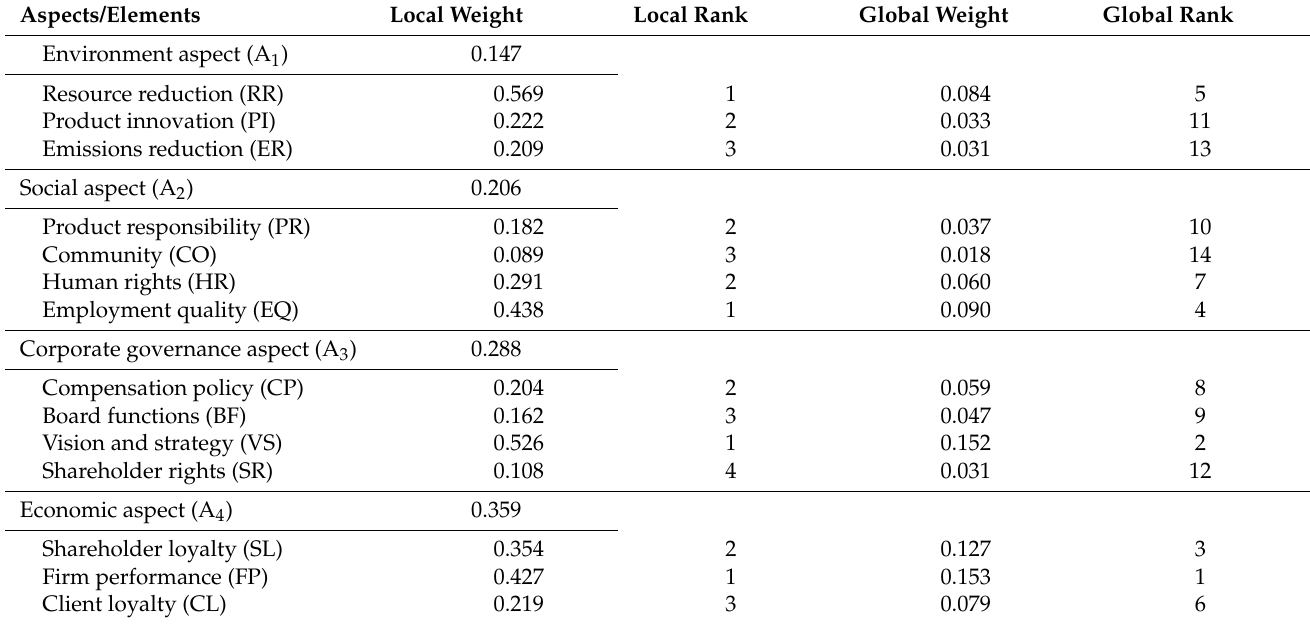
Table 2. The weights evaluation of CSR application in Taiwan during the COVID-19